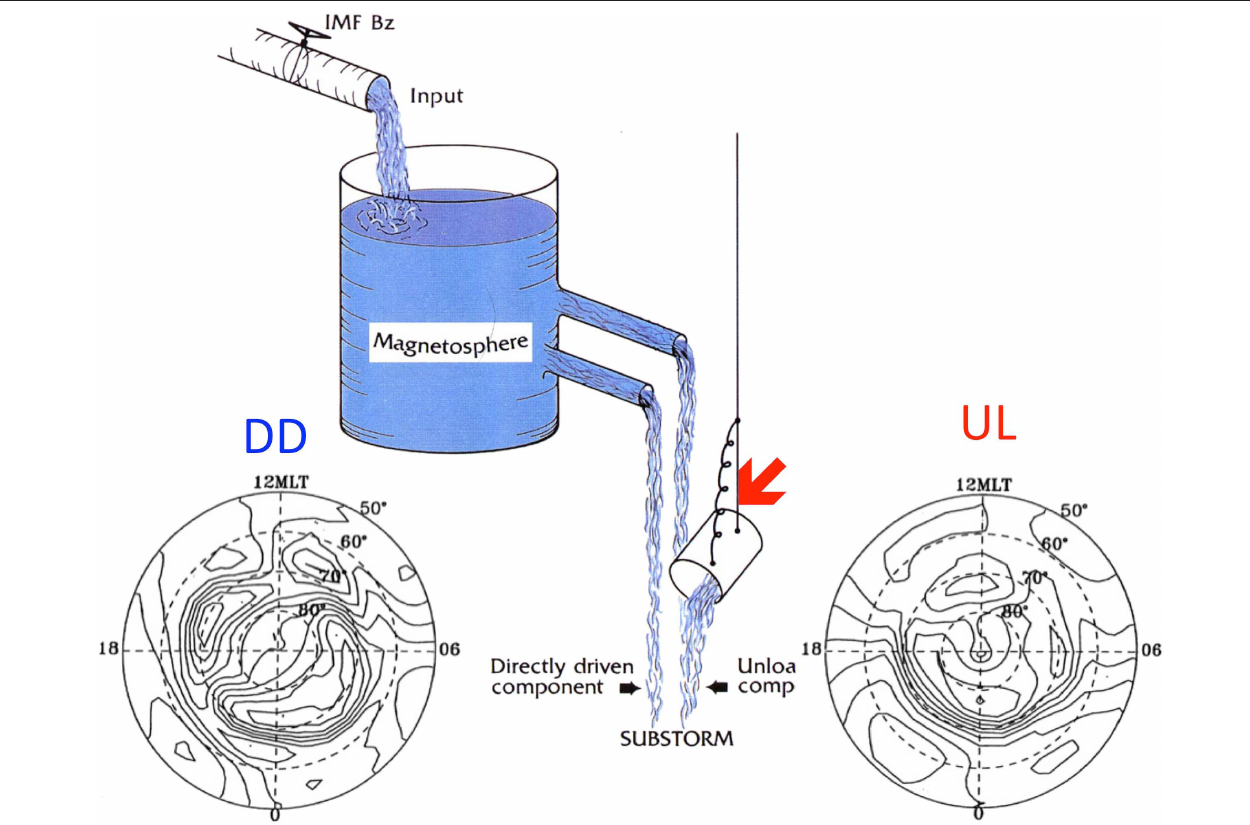
FIGURE 6 | An attempt to explain how the accumulated power (loaded energy) is generated by the dynamo flows; one is directly dissipated from the tank (magnetosphere), and other flows into the pitcher (the inductive circuit, red arrow) first and then unloaded suddenly. The former produces the directly driven (DD) current in the ionosphere, which is a two-cell current, while the latter produces the unloading (UL) current in the ionosphere, which is mainly a single-cell current (modified from Akasofu,